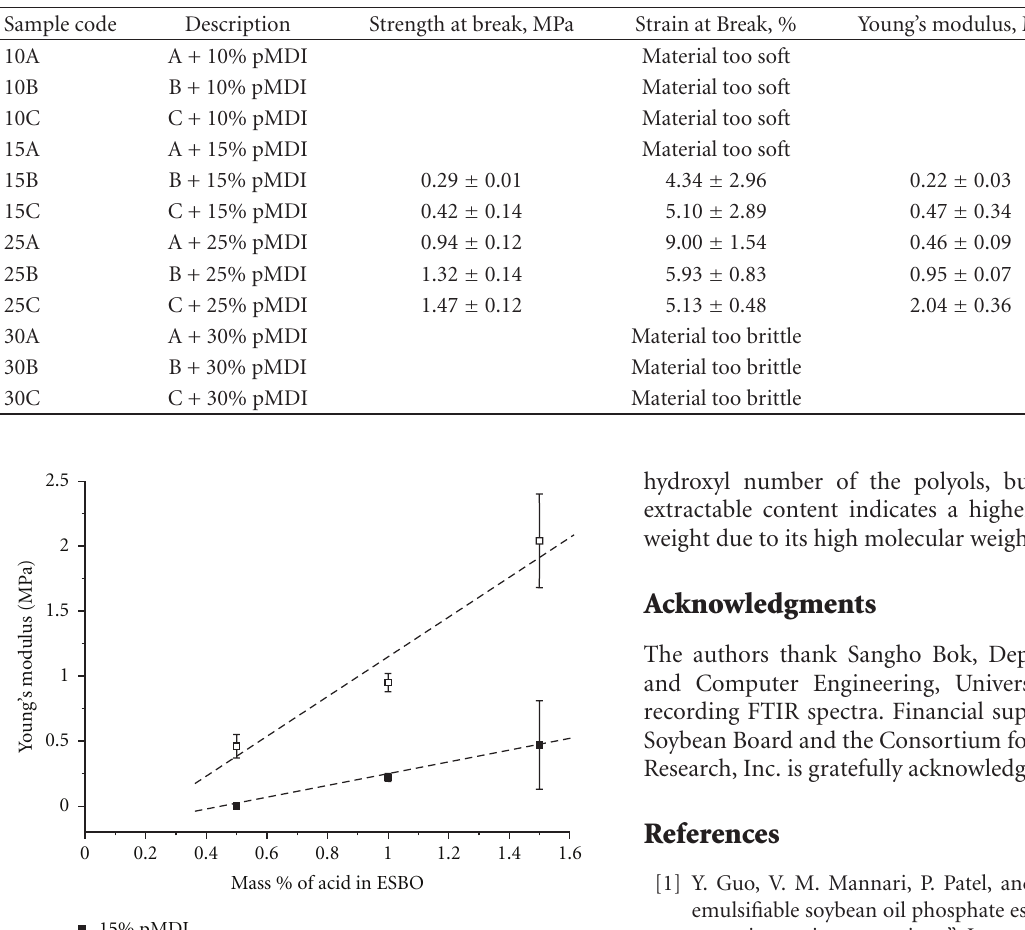
Table 4: Tensile and thermal properties of bioelastomers from acid-catalyzed epoxides of Table 3. Bioelastomers were evaluated at 10%–30% by weight pMDI based on acid-treated ESBO.